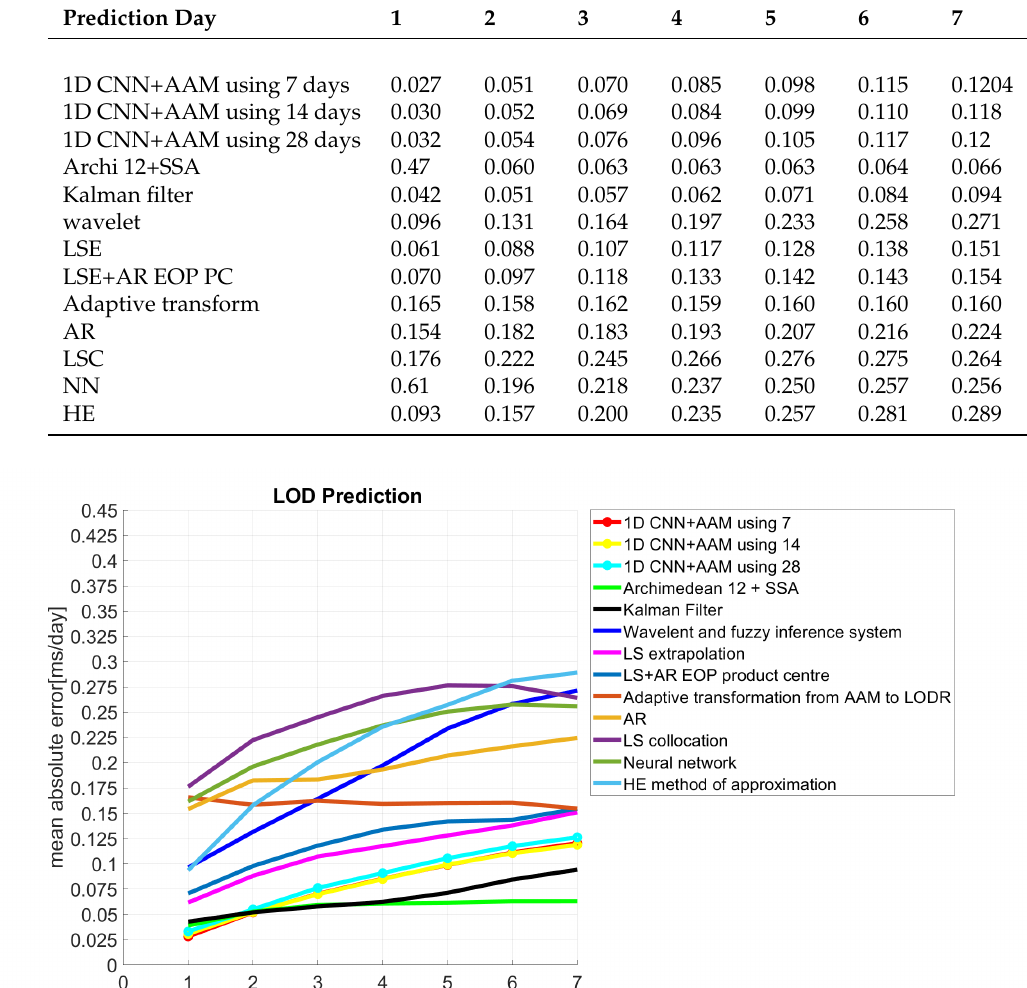
Table 2. Comparison of 1D CNN prediction and 2ns EOP PCC prediction errors. Units: (ms/day).